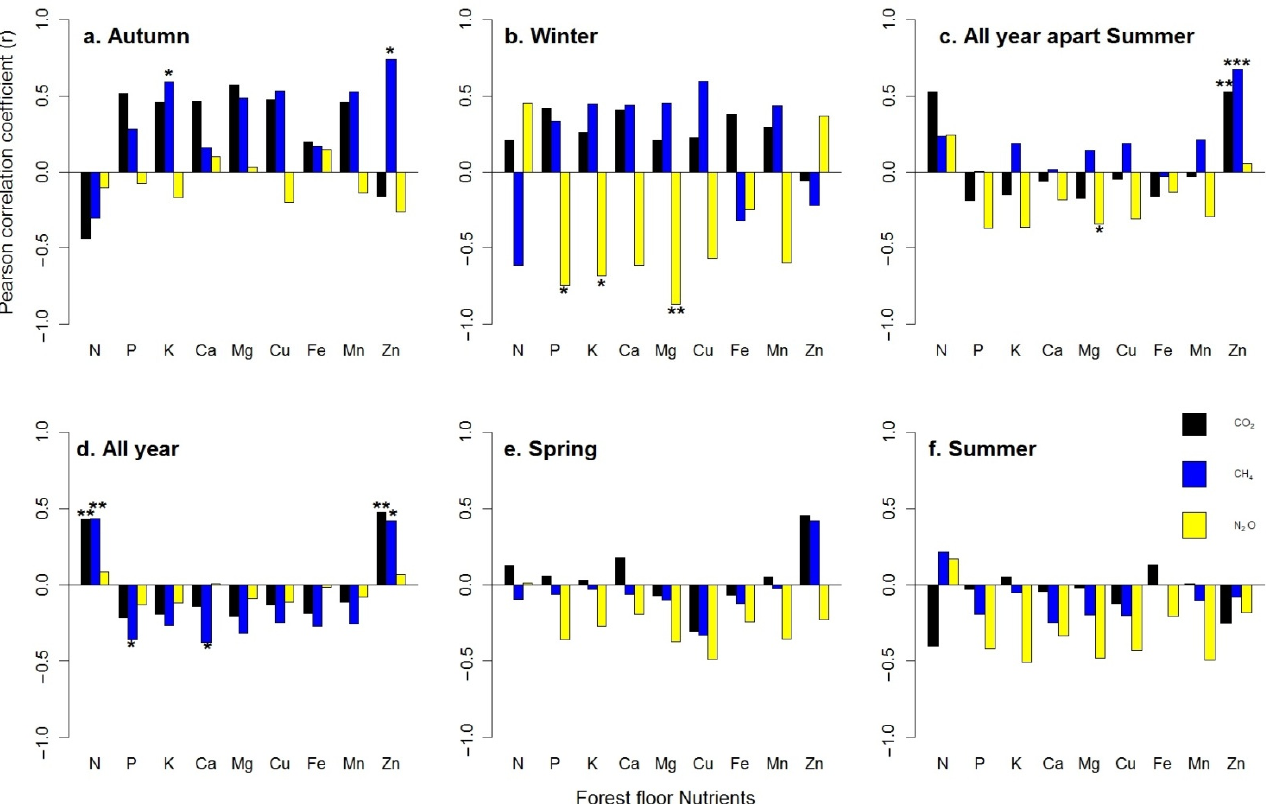
Figure 3. Seasonal pattern (( a ) autumn, ( b ) winter, ( c ) all year apart from summer, ( d ) all year, ( e ) spring, ( f ) summer) of forest floor nutrients’ correlation with GHG fluxes over the study period (16